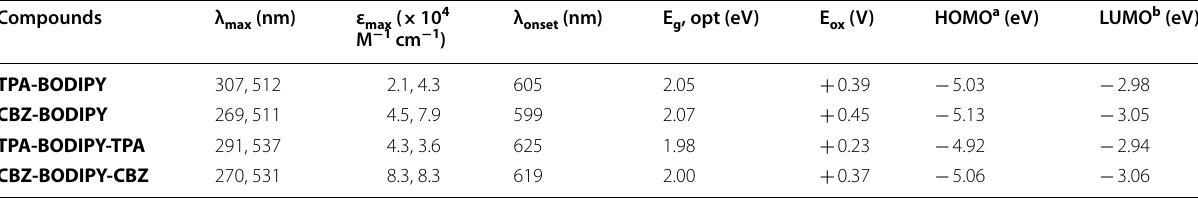
a HOMO energy is calculated from the equation, HOMO b LUMO energy is calculated from the equation, E